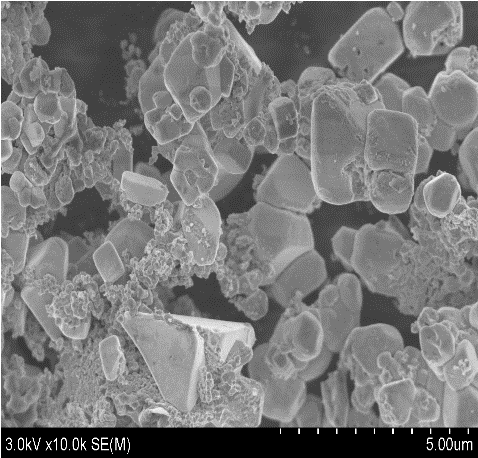
Figure 11. SEM images of the HCl and water-washed silver particles on the surface of copper sheet. [HCl] = 2% ( v / v ).